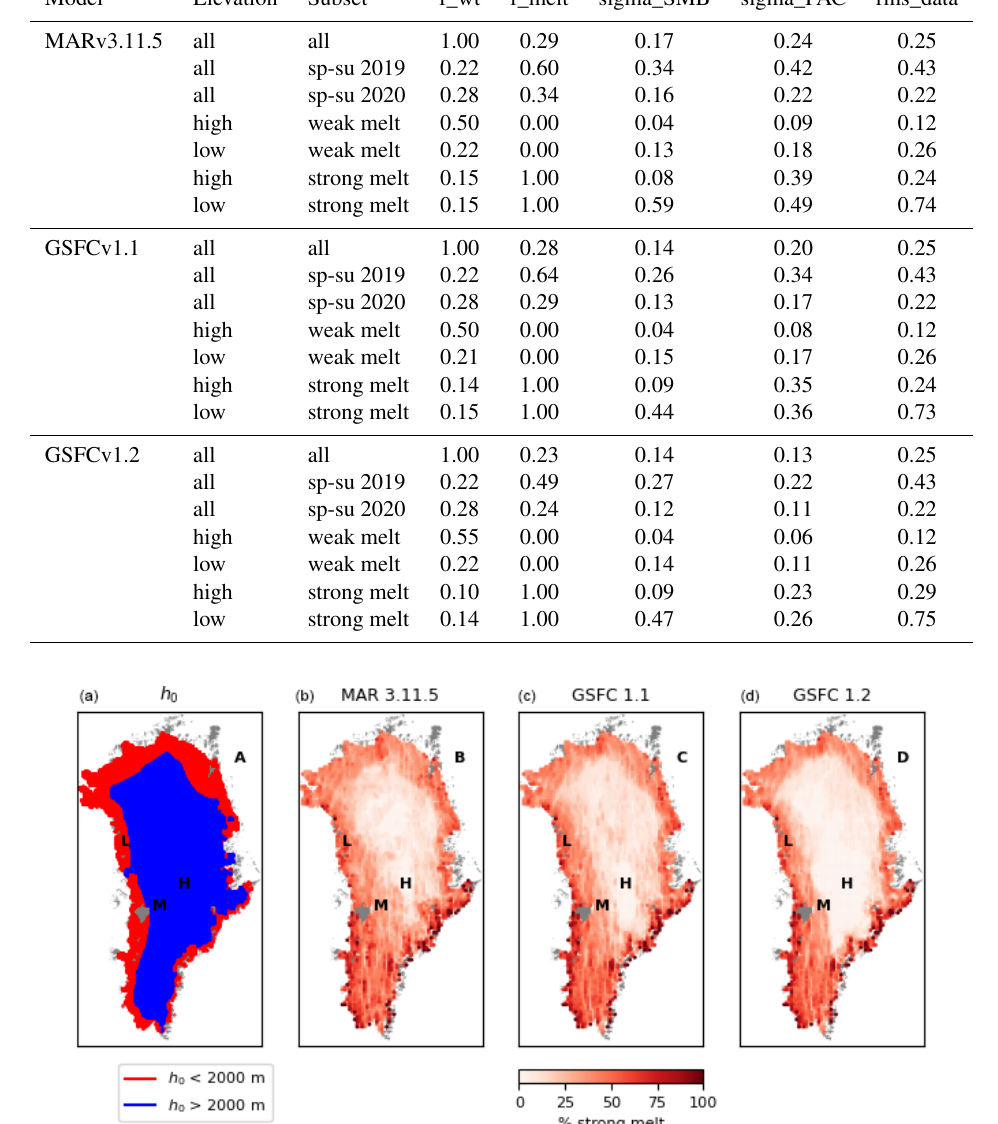
Figure 1. Spatial distribution of elevation and melt categories. Panel (a) shows the location of the low-and high-elevation data. Panels (b) , (c) , and (d) show the fraction of all points in 10 × 10km bins for each model that fall into the strong-melt ( z melt > 0 . 2 | dh m | ) category. Letters “H”, “M”, and “L” indicate locations for plots in Fig.